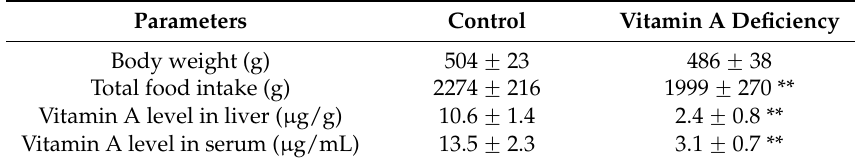
Table 1. The physiological and biochemical parameters of experimental